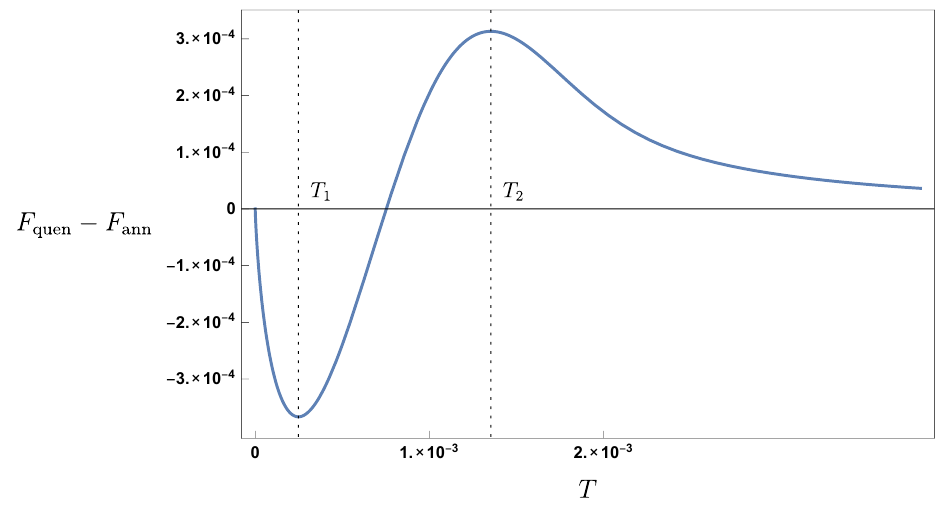
\ CGHS. The temperatures